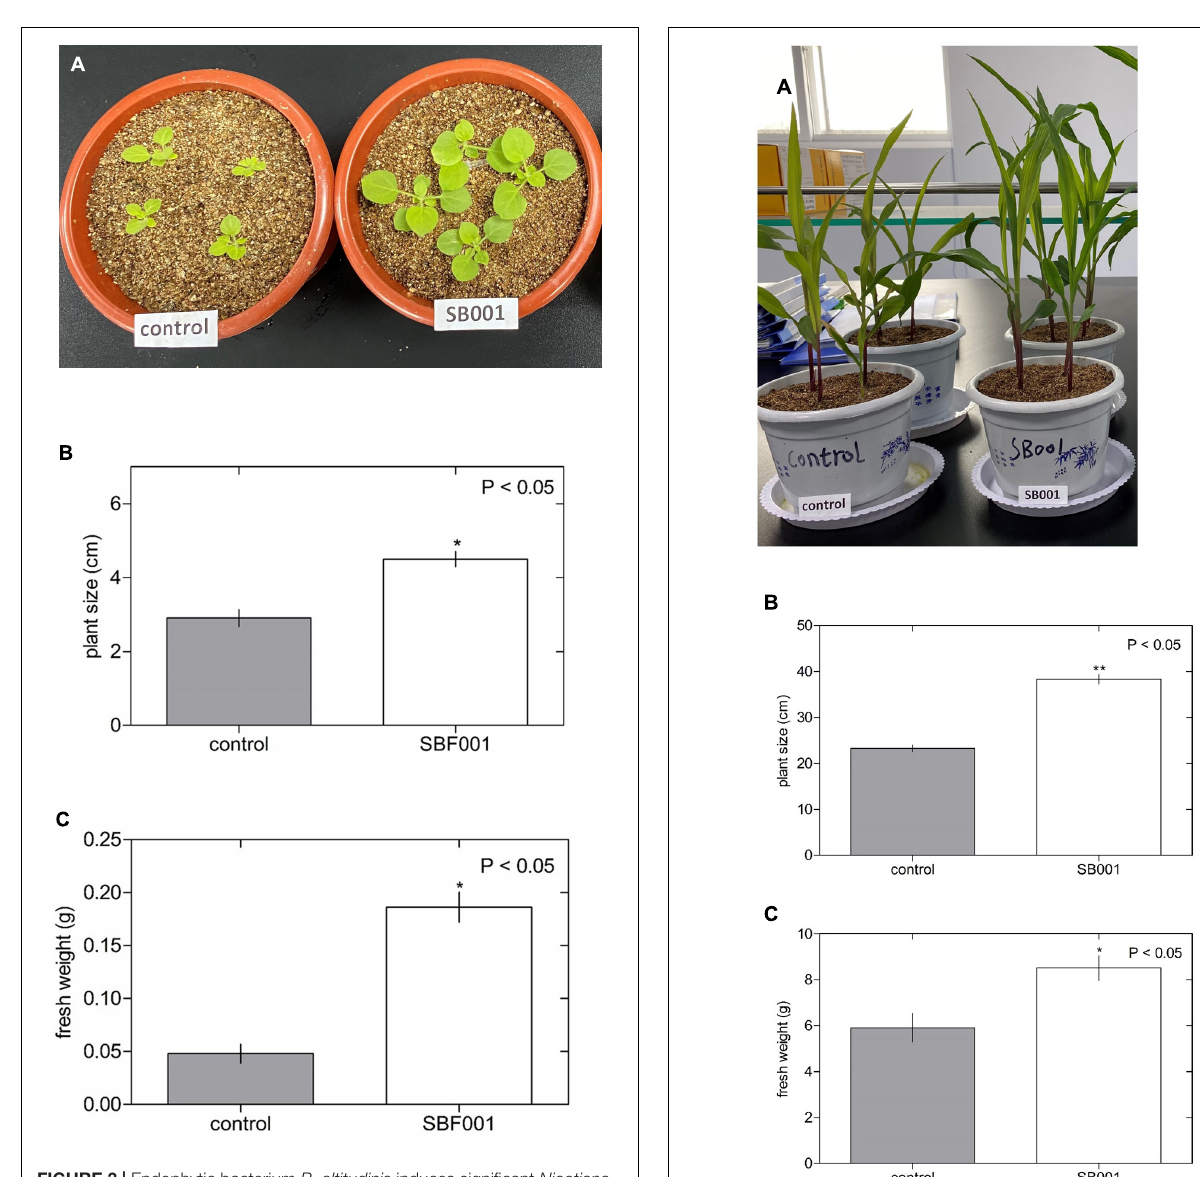
Trihelix transcription factor (TF) ASR3, TF MYB90, and O -methyltransferase family proteins were significantly repressed during the interaction ( Table 2 and Supplementary Table 4